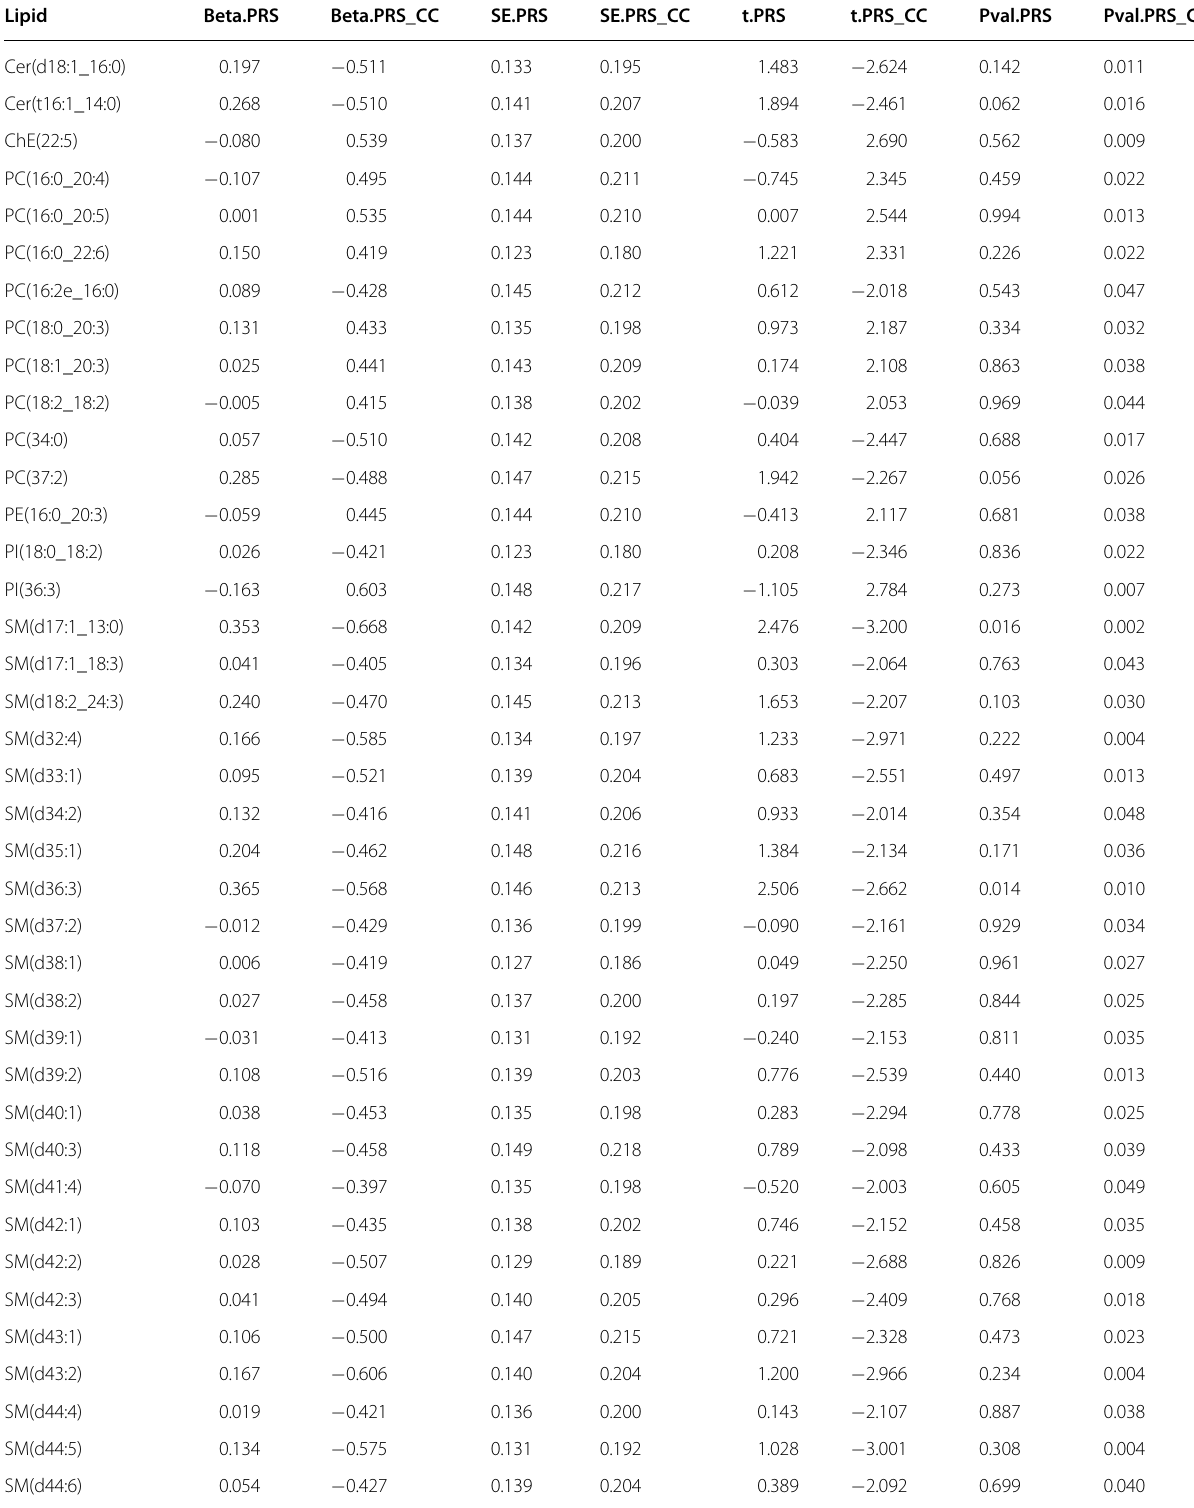
Table 3 Nominally signi fi cantly differential association of the AD risk PRS with lipids between AD and controls control.